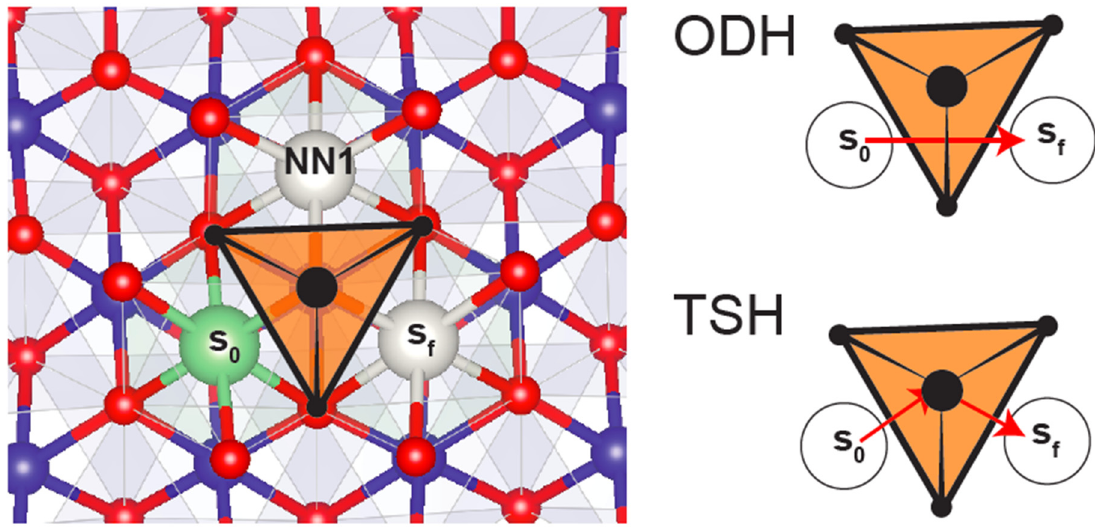
Figure 5. Li diffusion from site S 0 to S f in layered materials. View of Li x CoO 2 down the c -axis, with the top CoO 2 metal layer removed for clarity. The Li (green) layer and CoO 2 metal layer (Co: blue, O: red) below are shown. Black circles further indicate the O which coordinate the tetrahedral site colored in orange, showing how three of the tetrahedron faces are face-sharing with S 0 , NN1, and S f . The last face of the tetrahedron face-shares with Co in the metal layer below. Li in site S 0 can either diffuse from octahedral S 0 to octahedral s f via the edge-sharing connection, thus completing an octahedral dumbbell hop (ODH) illustrated by the single red arrow, or through the empty tetrahedral site via the tetrahedral site hop (TSH) mechanism illustrated by the two red arrows. Site NN1 (white) is vacant.